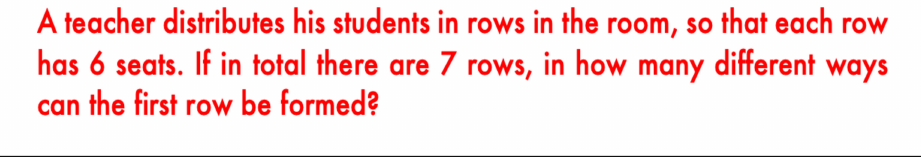
Figure 6. Example of task meaning M1 as a variable of interest (Adapted from [34] (p.